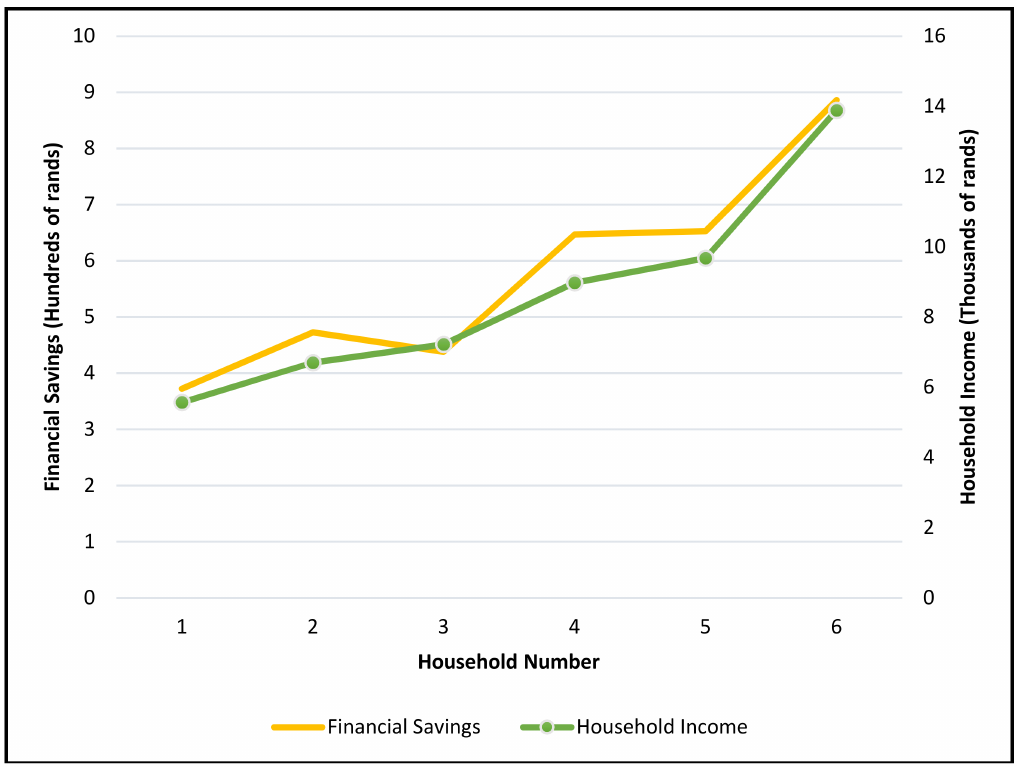
Figure 6. Relationship between household income and financial